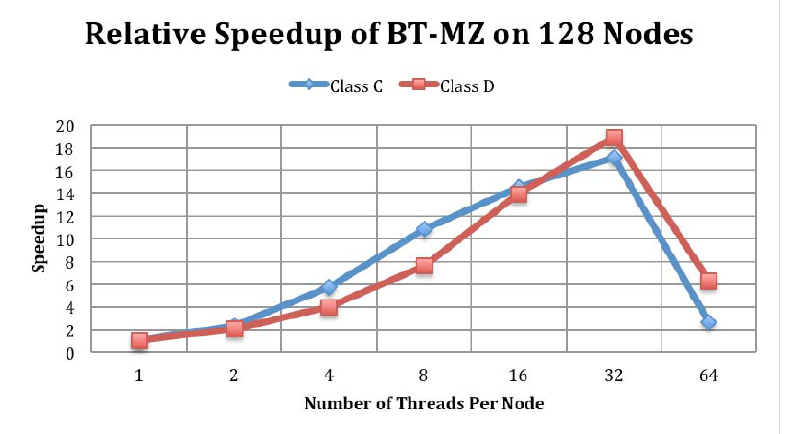
Figure 7. Performance comparison of BT-MZ on 128 Nodes with different number of threads per node